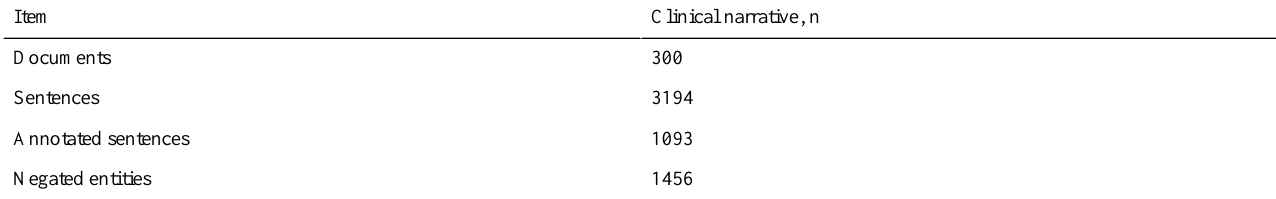
Table 8. IULA Spanish Clinical Record corpus